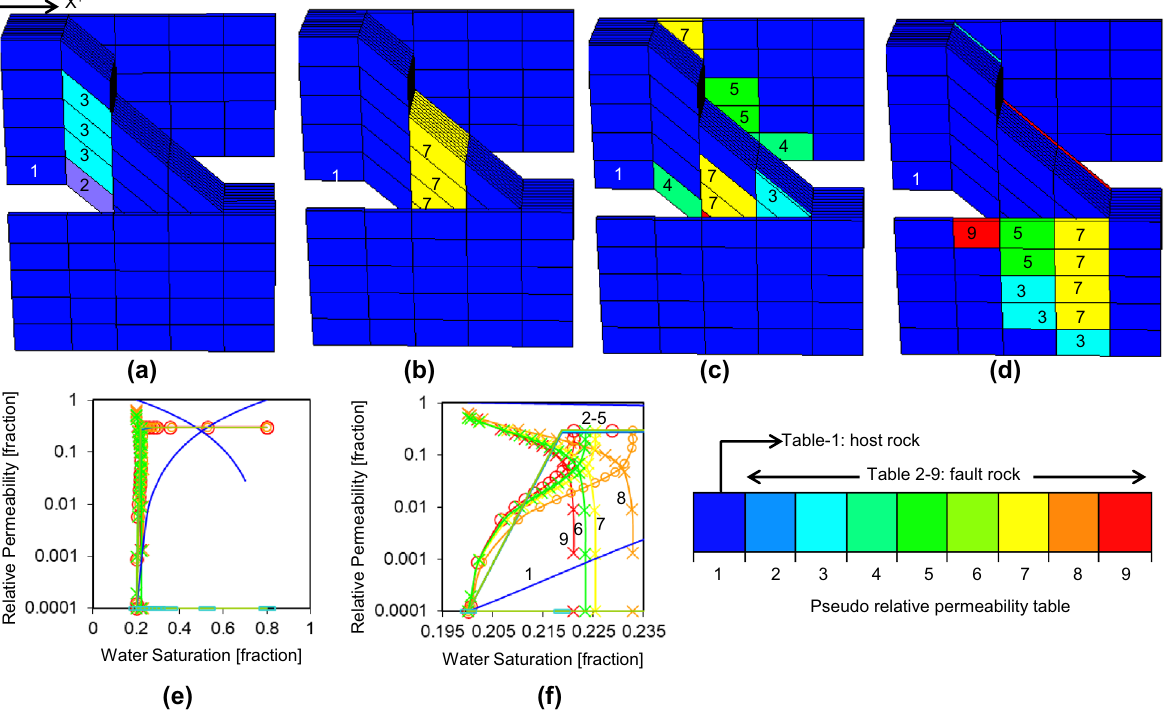
Figure 5. Indices for the directional, irreversible pseudo-relative permeability tables in the truth model for the X+ ( a ), X− ( b ), Y+ ( c ), and Y− ( d ) directions. ( e ) The host rock and eight pseudo-relative permeability functions shown with the same color scheme as ( a –d). ( f ) As ( e ), but limited to the water saturation range in which the functions are variable. Crosses are for oil, circles are for water.